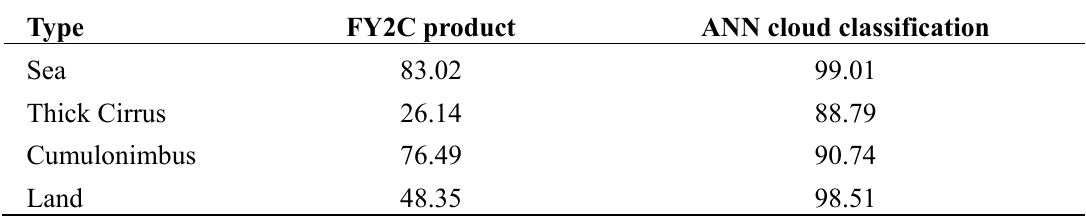
Table 6. Accuracy rate of FY-2C operational product and ANN model